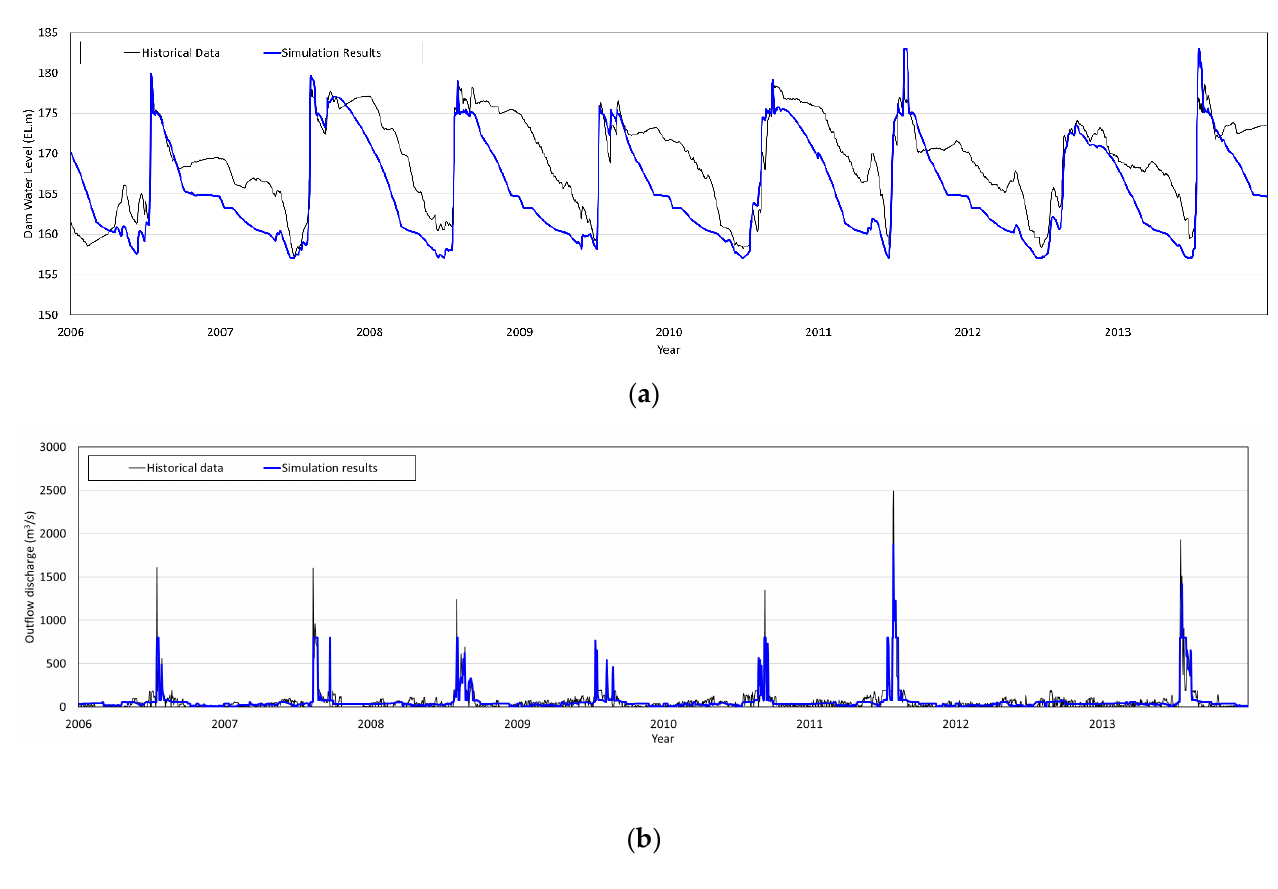
Figure 10. Comparison of historical data and simulation results. ( a ) Water level; ( b ) Outflow discharge. Table 4. Comparison of historical data and simulation results for power